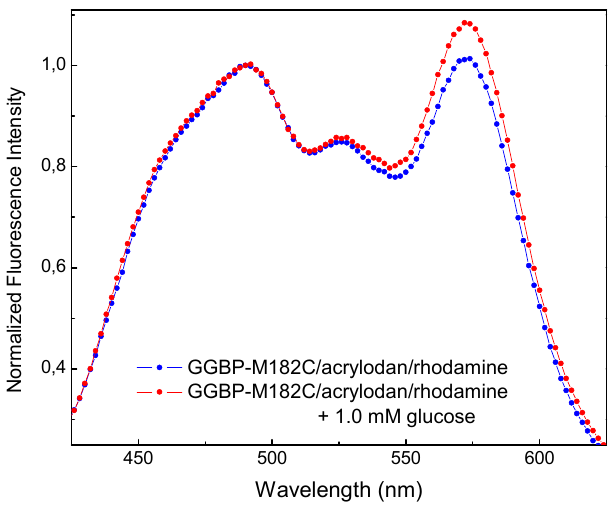
Figure 3. Emission spectra of GGBP-M182C labeled with acrylodan and rhodamine in the absence and in the presence of